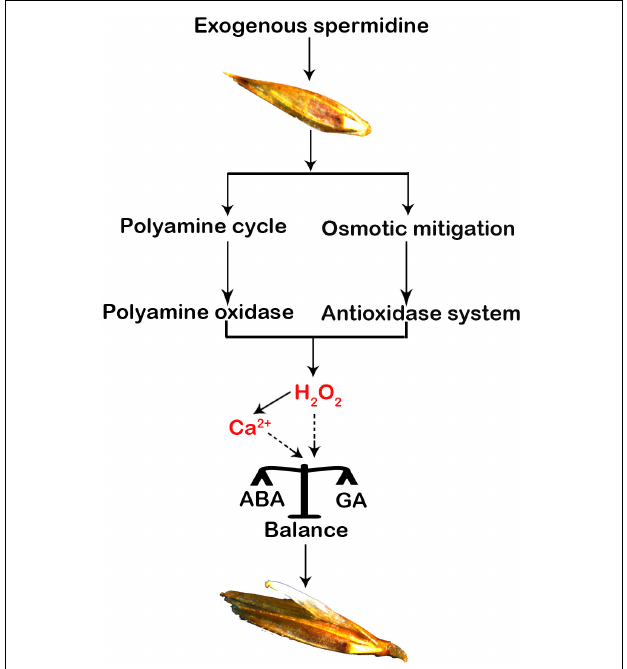
FIGURE 8 | A hypothetical modulation diagram of spermidine-mediated in the seeds of Leymus chinensis under salt-alkali stress. A “polyamine circle” was indicated (Pál et al.,